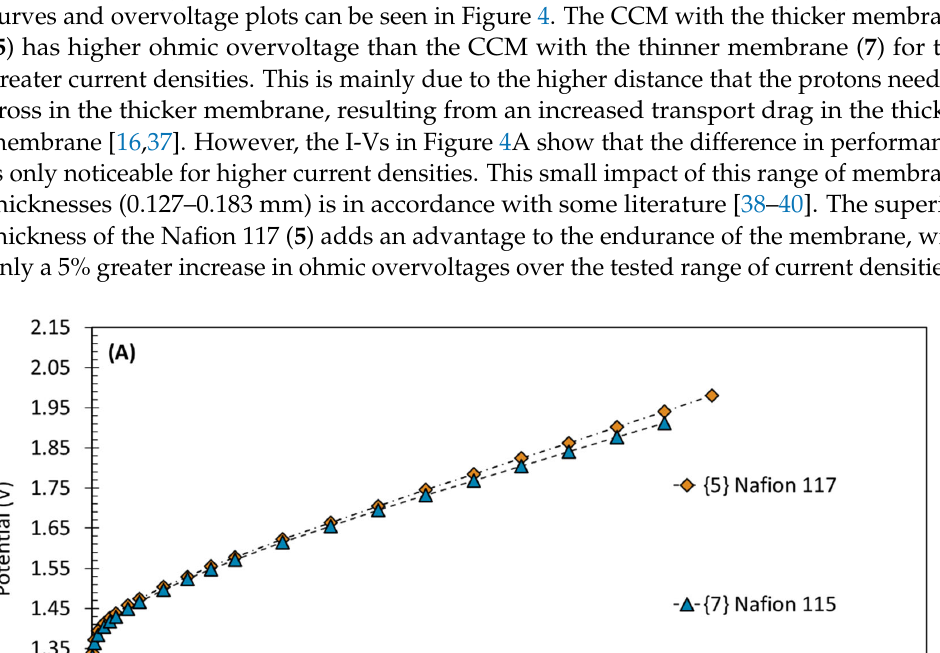
Figure 4. Data of CCMs with different membrane thicknesses operating at 80 °C. ( A ) ‐ I ‐ V curves, ( B ) ‐ activation overpotentials, ( C ) ‐ ohmic overpotentials. 3.3. Catalyst Type Effect As depicted in Figure 5, the CCM with IrRuOx catalyst ( 7 ) is at the same time the CCM with lower activation overvoltage and higher ohmic overvoltage at higher current densities. The lower activation overvoltage of this catalyst is in accordance with the literature, as it is the catalyst with the highest kinetic activity for WE used in this set